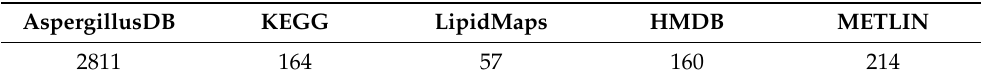
Table 1. Number of Aspergillus compounds in Aspergillus DB, CMM, KEGG, LipidMaps, HMDB, and METLIN.